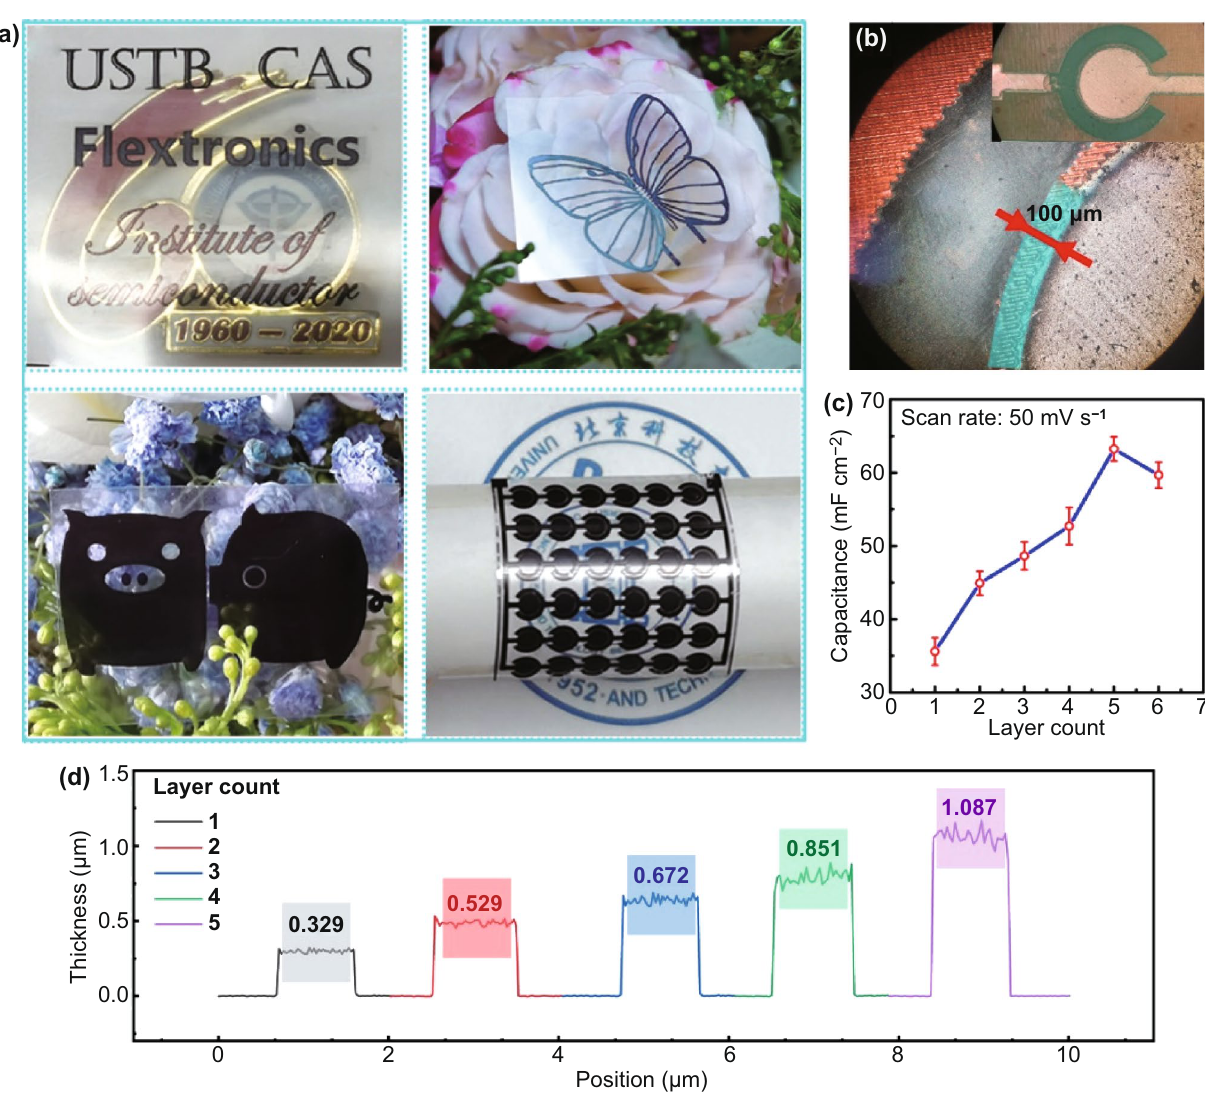
Fig. 2 Design of MSC devices with various patterns, electrode structure, and array on flexible PET substrate. a Optical images of laser written “USTB, CAS, Flextronics, Institute of semiconductor” words, cartoon MSC, butterfly-shaped Zn-ion MSC, and MSC array. b Microphotography of the concentric circular MSC with a 100 µm gap between Zn anode and Ti 3 C 2 T x cathode. c Capacitance of the Ti 3 C 2 T x cathode with increasing layers in Zn-ion MSC. d Thickness of the Ti 3 C 2 T x cathode related to different layer